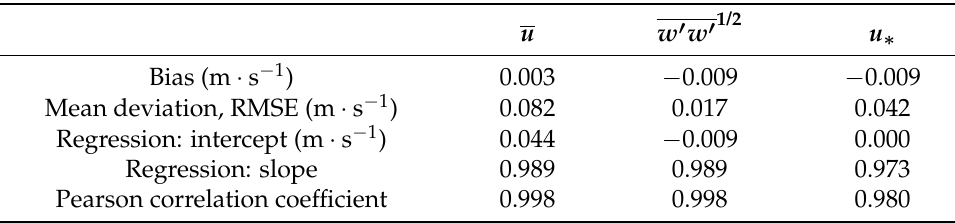
Figure 11. Results of the 2019 comparative measurement between the PTB bistatic lidar and a CSAT3B ultrasonic anemometer mounted on top of a 30 m mast in turbulent flow, showing orthogonal linear regressions of the average horizontal wind 1/2 velocity component u , of the fluctuation of the vertical wind velocity component w (cid:48) w (cid:48) and of the shear stress velocity u ∗ . Table 1. Statistical parameters of the 2019 comparative measurement between the PTB bistatic lidar and a CSAT3B ultrasonic anemometer mounted on top of a 30 m